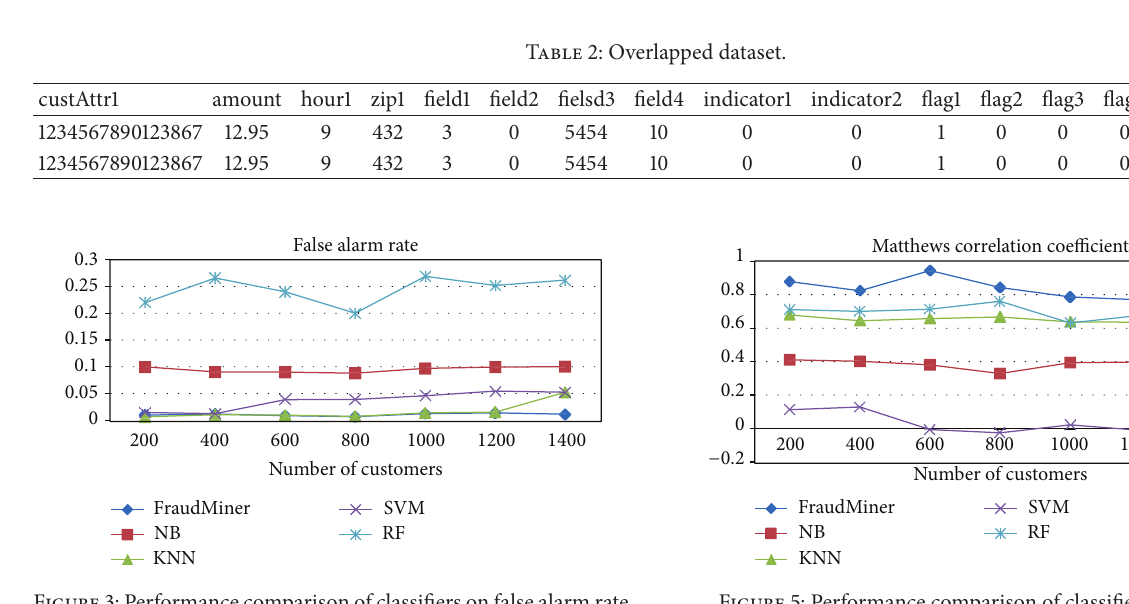
Figure 5: Performance comparison of classifiers on